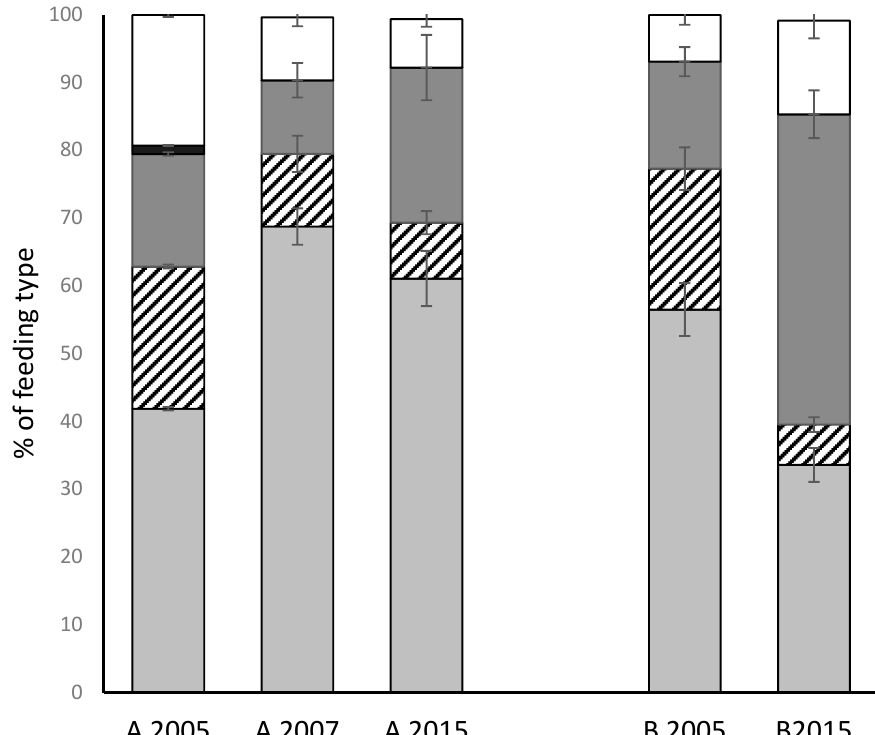
Figure 2. Average percentage of the total recovered omnivorous (white), predatory (black), bacterivorous (light grey), fungivorous (stripped) and herbivorous (dark grey) nematode feeding types as identified from the evaluation of ~120 nematodes from each sample ( n ≥ 6) from field A and field B over each year of sampling. Error bars represent the standard errors of the means.